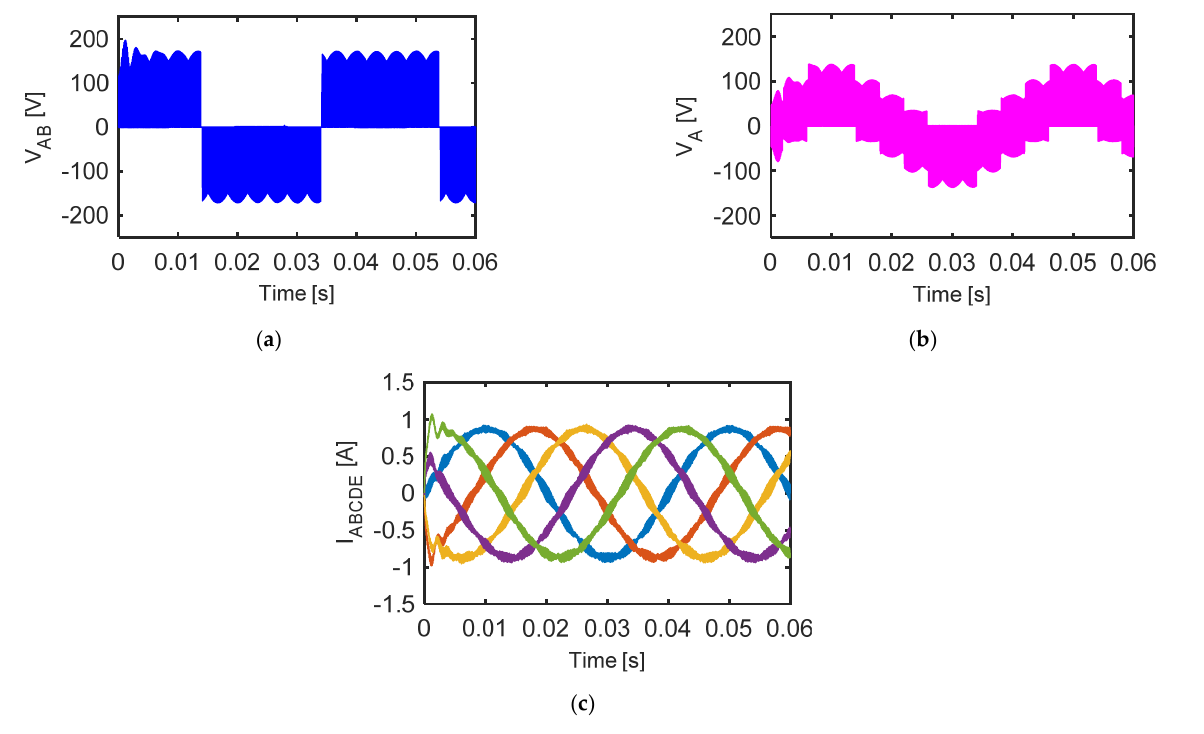
Figure 18. Simulation results at 25 Hz output frequency ( a ) output line voltage, ( b ) output phase voltage and ( c ) output phase currents.